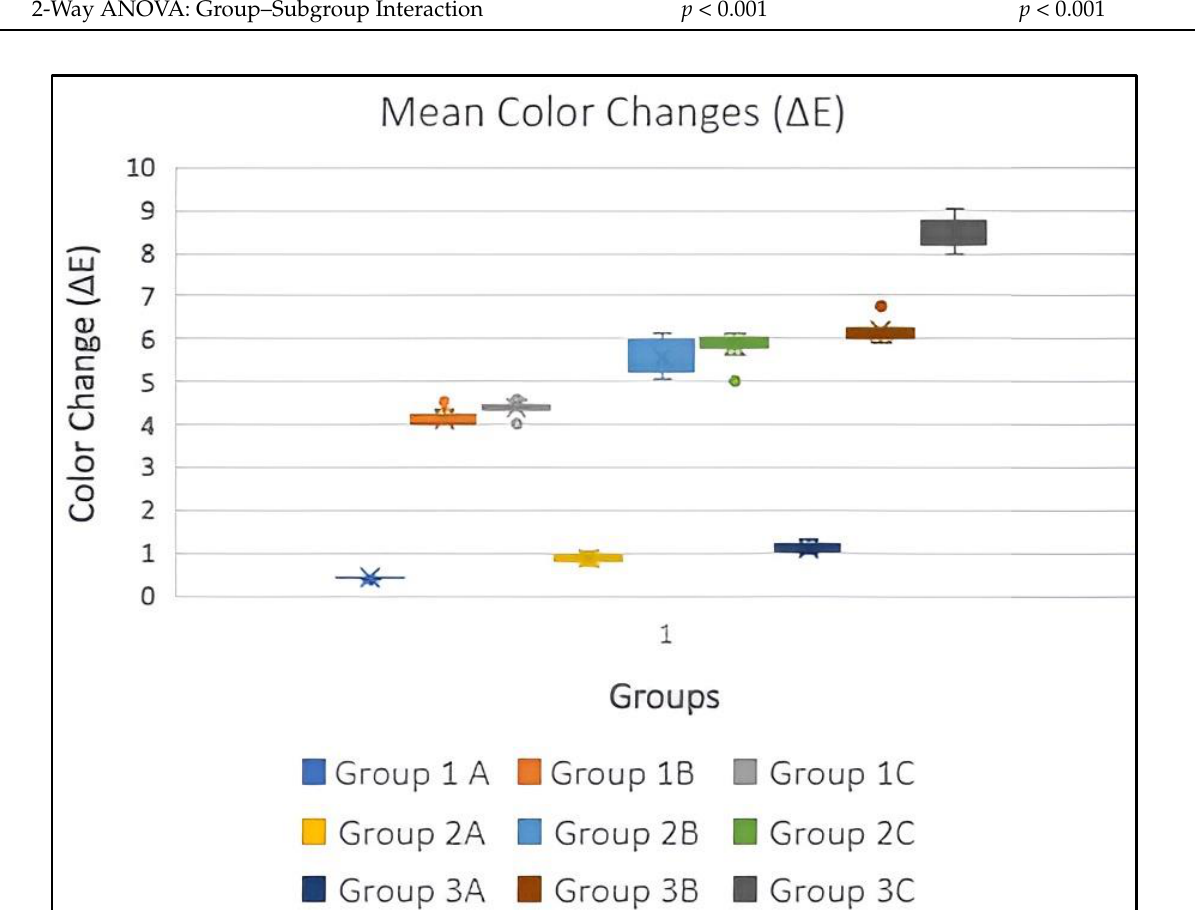
Figure 7. Mean color changes (ΔE) in all groups.